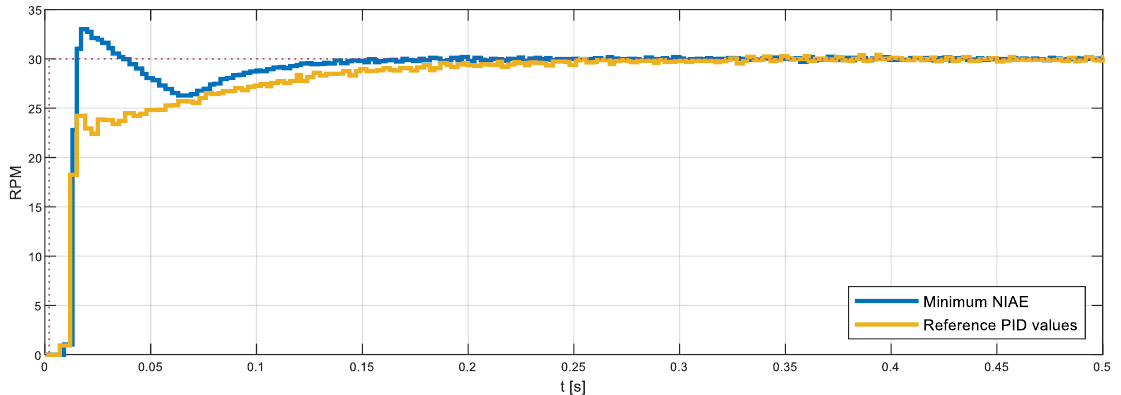
Figure 22. Step overshoot results measured in the real motor using the reference PID parameters obtained with the FRB PID tuner procedure (yellow line) and the best PID parameters, which minimize the NIAE. The target speed is 30 rpm.